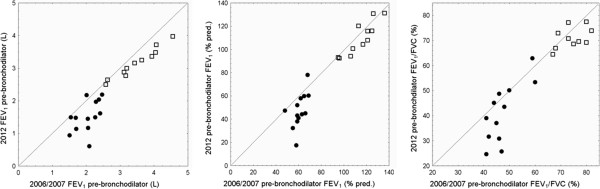
Change in pre-bronchodilator FEV1 (L), FEV1 (% pred.) and FEV1/FVC (left, middle, right) from 2006/2007 to 2012 in smokers with COPD (circles) and former healthy smokers (open squares). A larger drop below the line of identity indicates a larger decline in the respective lung function level. The changes with respect to GOLD category as listed in the text were done using post-bronchodilator values, which are slightly higher as compared to the pre-bronchodilator values displayed in this figure.